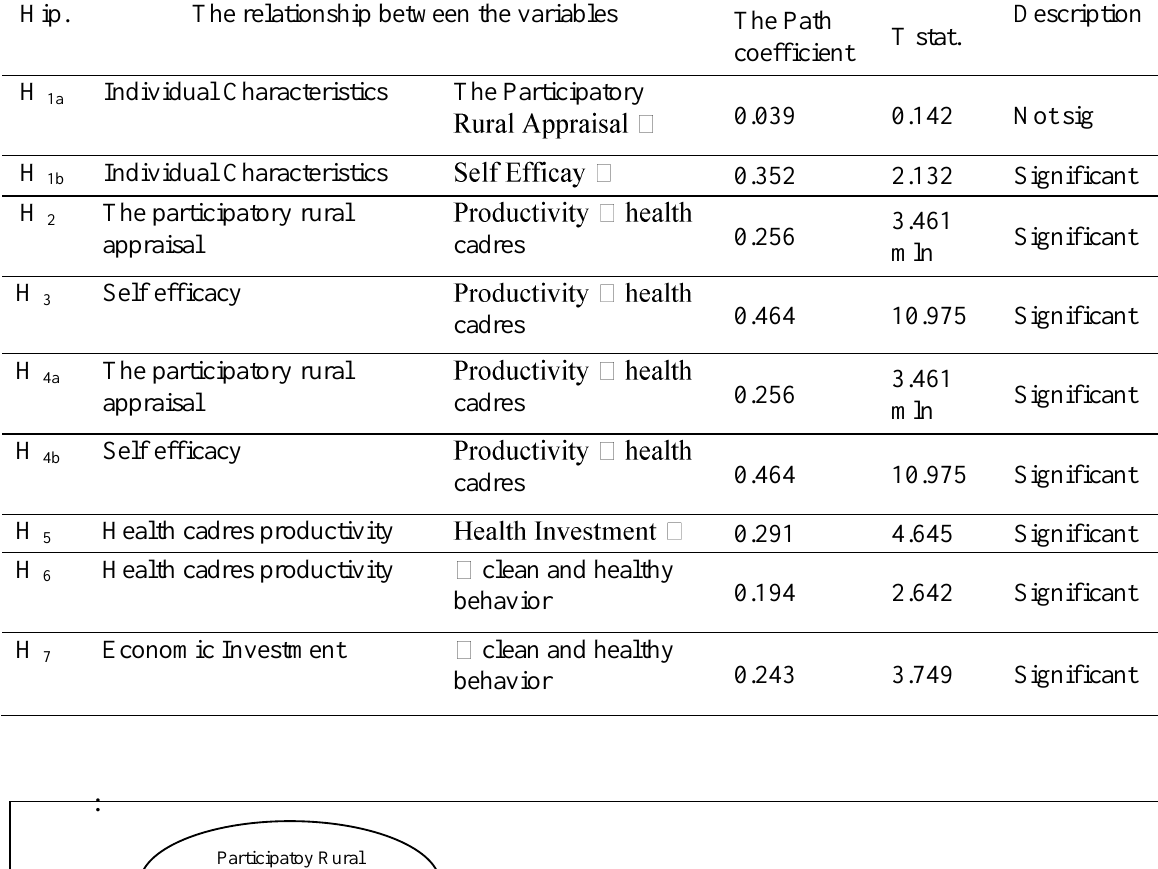
Table 1 Results of the Inner Weight and hypothesis test Hip.